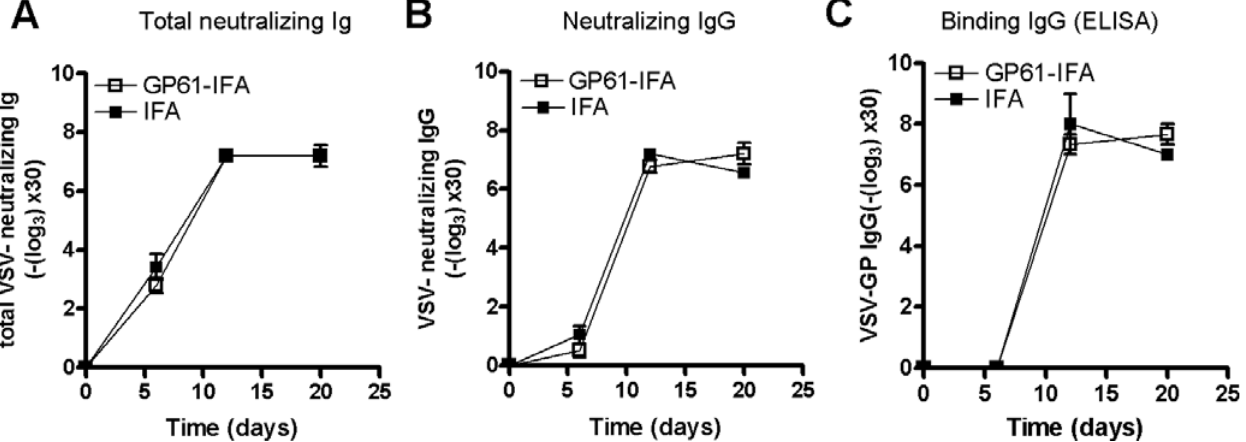
Figure 4. LCMV-GP specific peptide tolerisation does not affect antibody production against third party pathogen. C57BL/6 were tolerised with 100 m g GP61-IFA at day -9, -6 and -3. At day 0, mice were infected with 2 6 10 6 PFU of vesicular stomatitis virus (VSV). Neutralizing antibodies against VSV-glycoprotein were measured by VSV neutralisation assay; total neutralizing Ig (A) and neutralizing IgG (B). VSV-glycoprotein binding IgG was measured by ELISA (C).